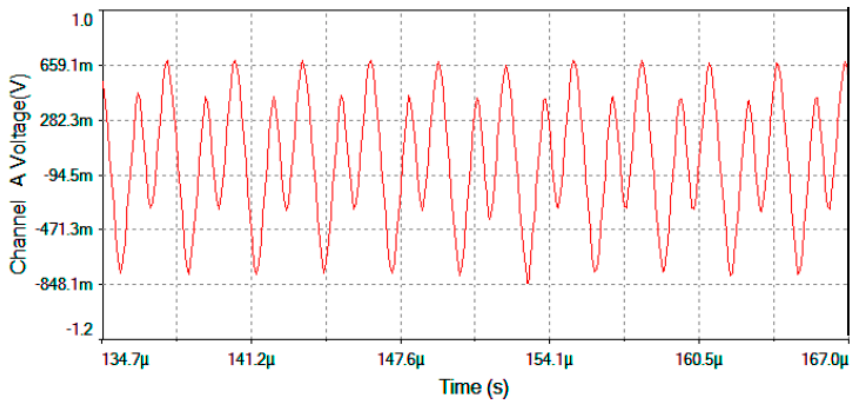
Figure 17. V multiplier output voltage after the Analog Multiplier for Ω = +30 °/s.